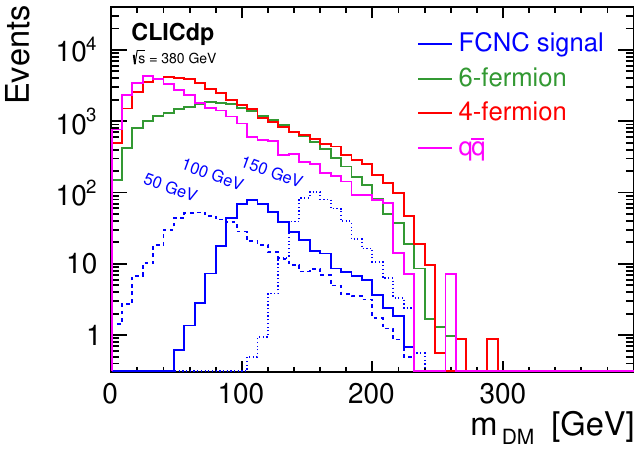
Figure 30. Distribution of the reconstructed invariant mass of the invisible decay product for the FCNC decay t ! cE = , reconstructed at 380 GeV CLIC after preselection cuts. The background contributions coming from 6-fermion (green histogram), four-fermion (red) and quark pair (magenta) production processes are normalised to 1.0 ab (cid:0) 1 while the signal samples, for the assumed mass of the invisible scalar of 50, 100 and 150 GeV (blue histograms) are normalised to BR(t ! cE = ) = 10 (cid:0) 3